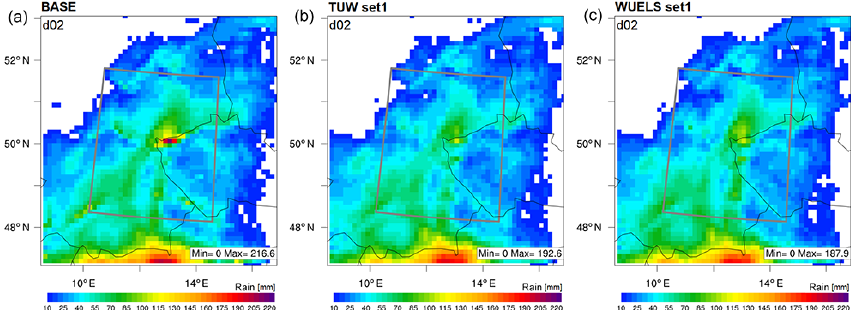
Figure 13. Total precipitation accumulated for 72h (31 May 2013 00:00UTC–3 June 2013 00:00UTC) for the WRF model forecasts: BASE (a) , TUW set1 (b) and WUELS set1 (c) . The grey line indicates the boundaries of the GNSS tomography models’ inner domain.